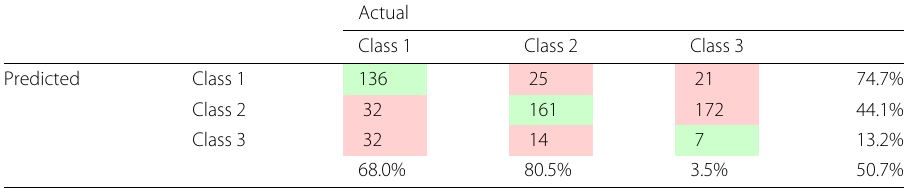
Table 5 Confusion matrix using features obtained with WOSA ( K = 8). Total classification accuracy is 50.7%